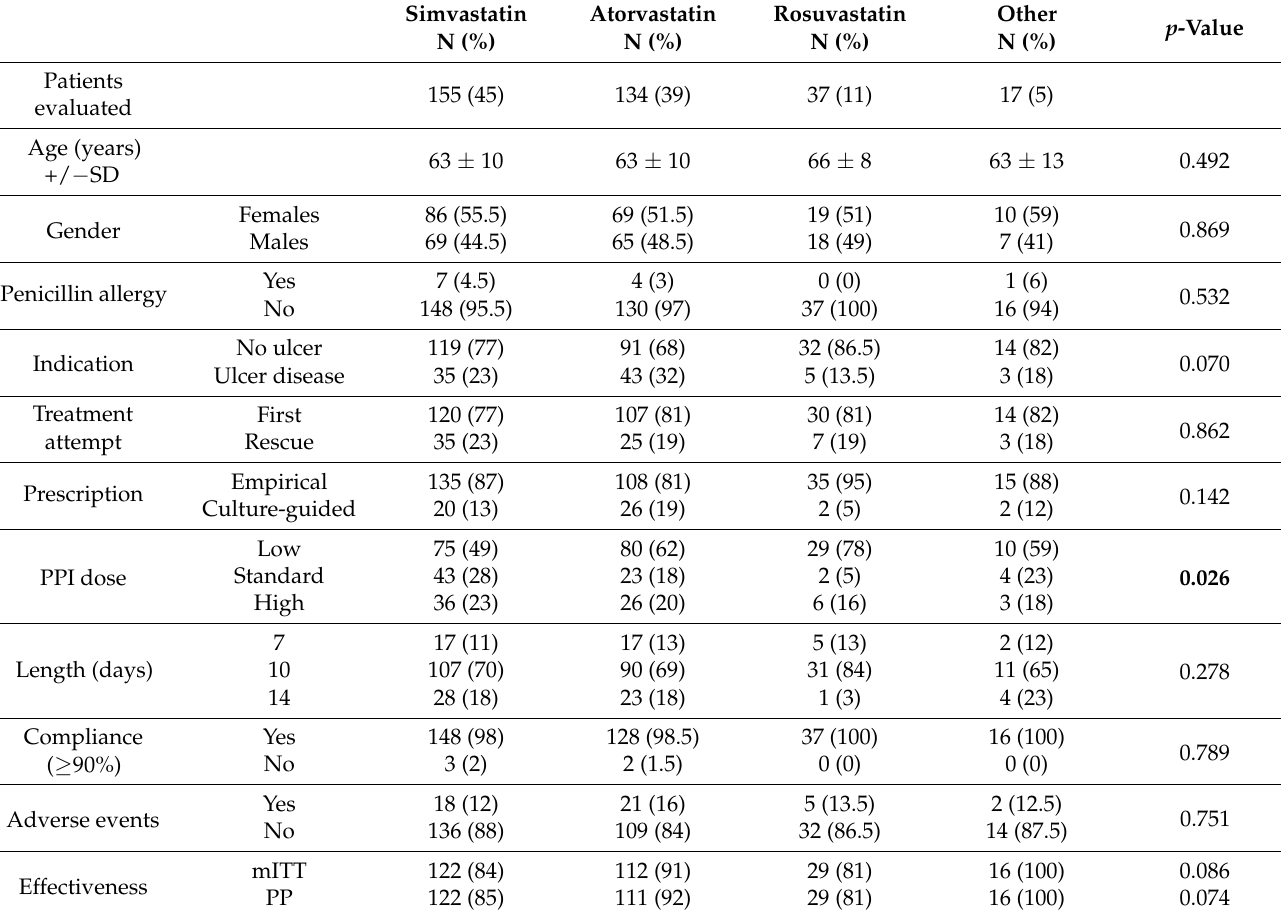
Table 2. Demographic analysis of the statin cohort stratified by type of